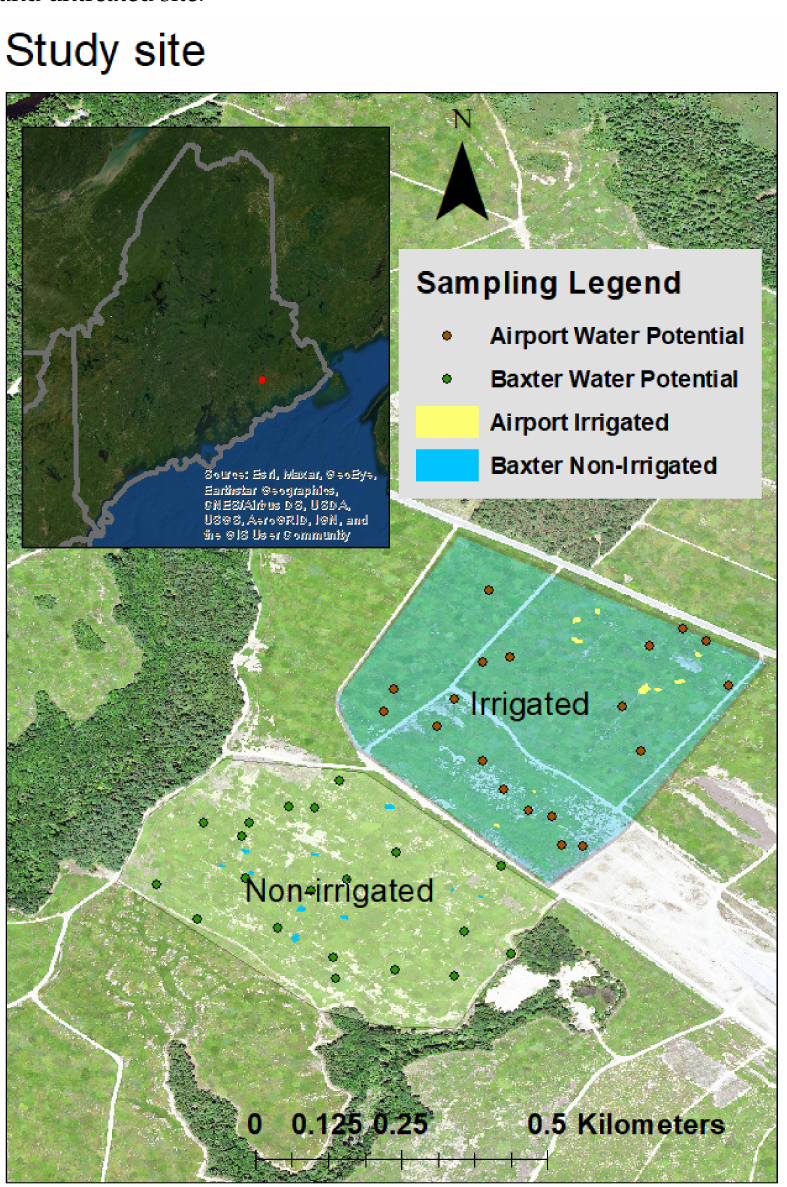
Figure 1. Study site of the irrigated field (upper light blue polygon) and non-irrigated field (lower light green polygon) with field sampling points and